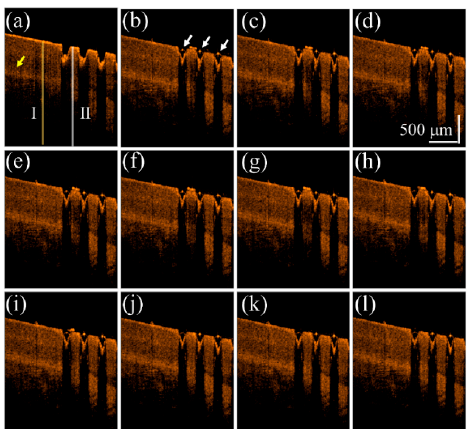
Figure 2. Time-series 2D OCT images obtained at the same location of the fingernail after 50 mJ fractional laser exposure. OCT images obtained ( a ) before the liquid drug application and at ( b ) 0 s, ( c ) 0.2 s, ( d ) 0.4 s, ( e ) 0.6 s, ( f ) 0.8 s, ( g ) 1.0 s, ( h ) 2.0 s, ( i ) 4.0 s, ( j ) 6.0 s, ( k ) 8.0 s, and ( l ) 10.0 s after the liquid drug application. The white arrows indicate that the stronger OCT backscattered signal resulted from the aggregation of drug particles. The yellow arrow indicates the nail bed. The yellow and white lines indicate the locations for estimation of the averaged A-scan profiles of the unexposed and treated regions.